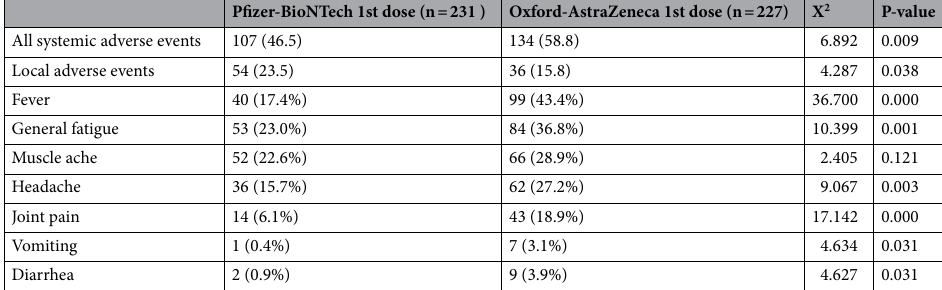
Table 3. Comparison of local and systemic adverse events between first dose of both studied vaccines.